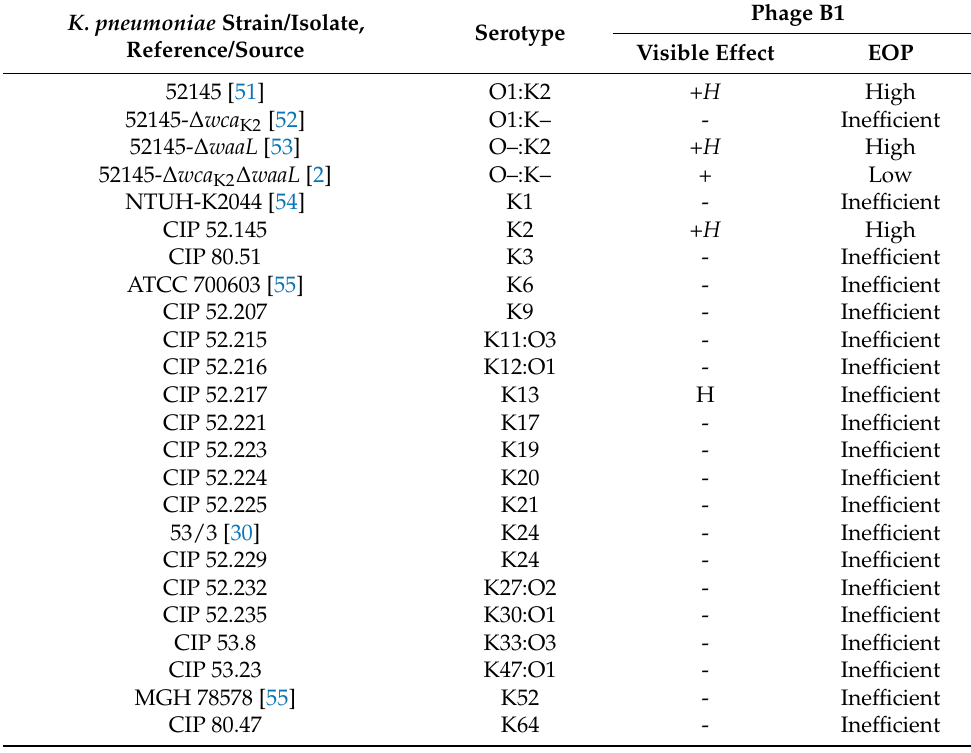
Table 1. Bacterial strains used in this study, and effect of B1 phage obtained by spot testing. Results are the mean of three different experiments. +: clear lysis, − : no effect, H : turbid ring around lysis (halo), H: turbid spot without lysis. The phage efficiency was classified as highly productive (efficiency of plating (EOP) ≥ 0.5), moderately productive (0.1 ≤ EOP < 0.5), low productive (0.001 < EOP < 0.1), or inefficient (EOP ≤